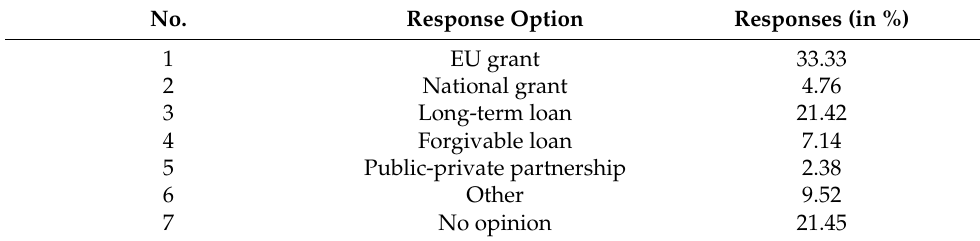
Table 7. Interest in types of ESCO services. Source: CAWI survey (multiple choice